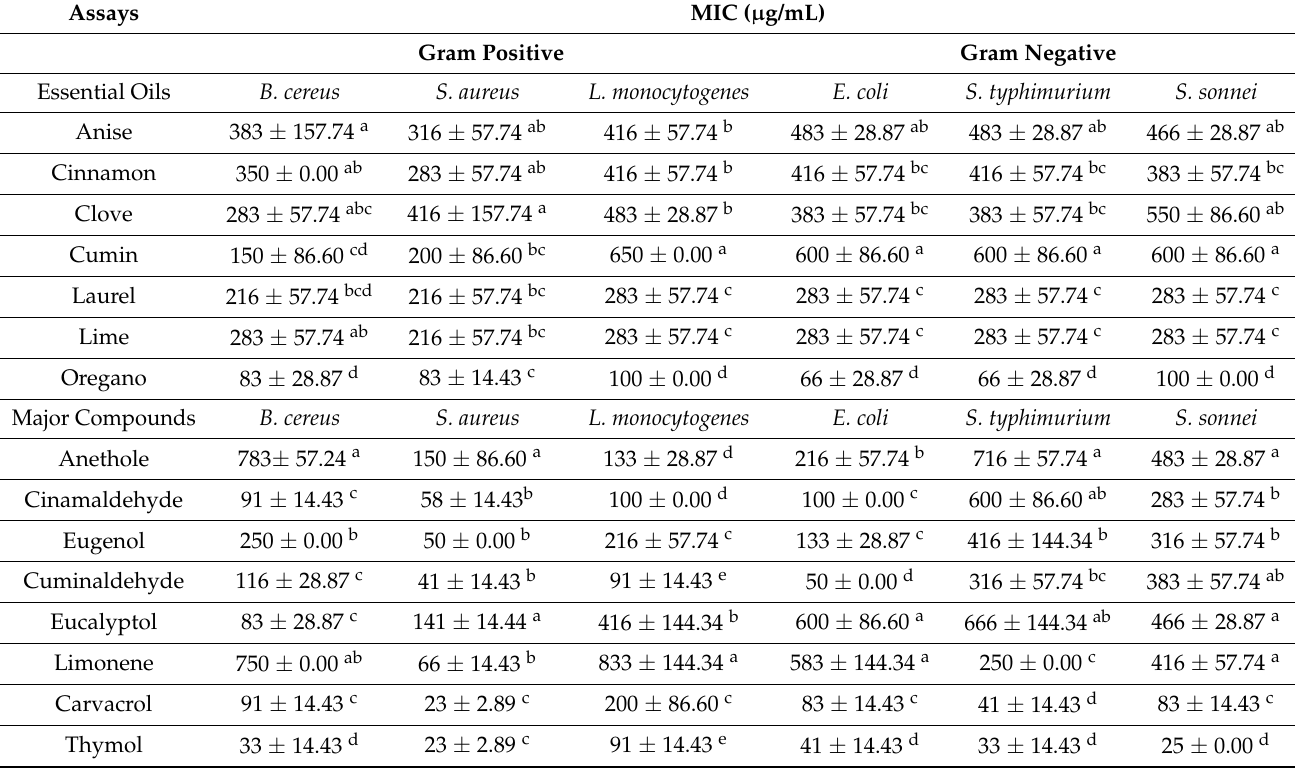
Table 2. Antibacterial activity of essential oils and their majority